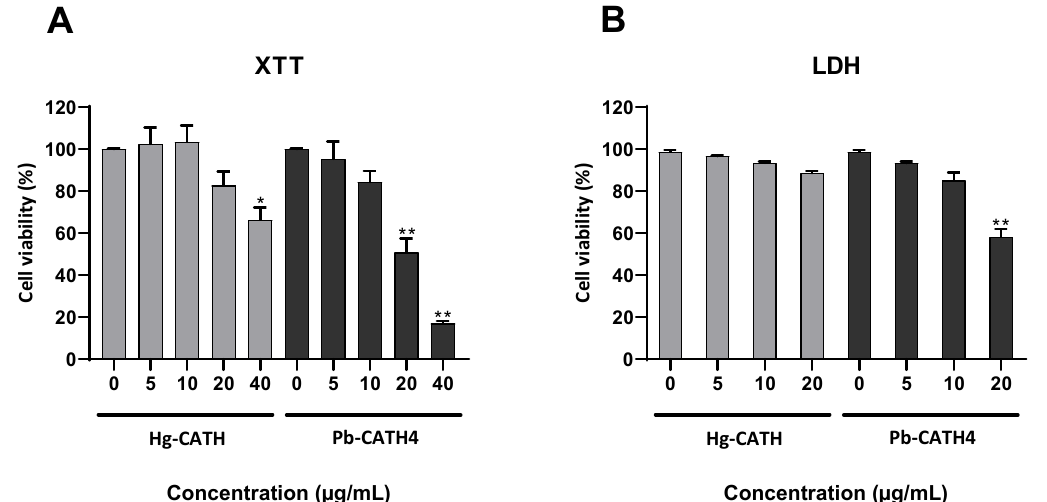
Figure 2. Evaluation of Hg-CATH and Pb-CATH4 cytotoxicity on primary human keratinocytes. Keratinocytes were exposed to Hg-CATH or Pb-CATH4 for 24 h. Cell viability was evaluated using the XTT cell viability assay ( A ) or LDH assay ( B ). Data are represented as mean + standard error of mean (SEM) of four independent experiments. * p < 0.05, ** p < 0.01 compared with the untreated control.